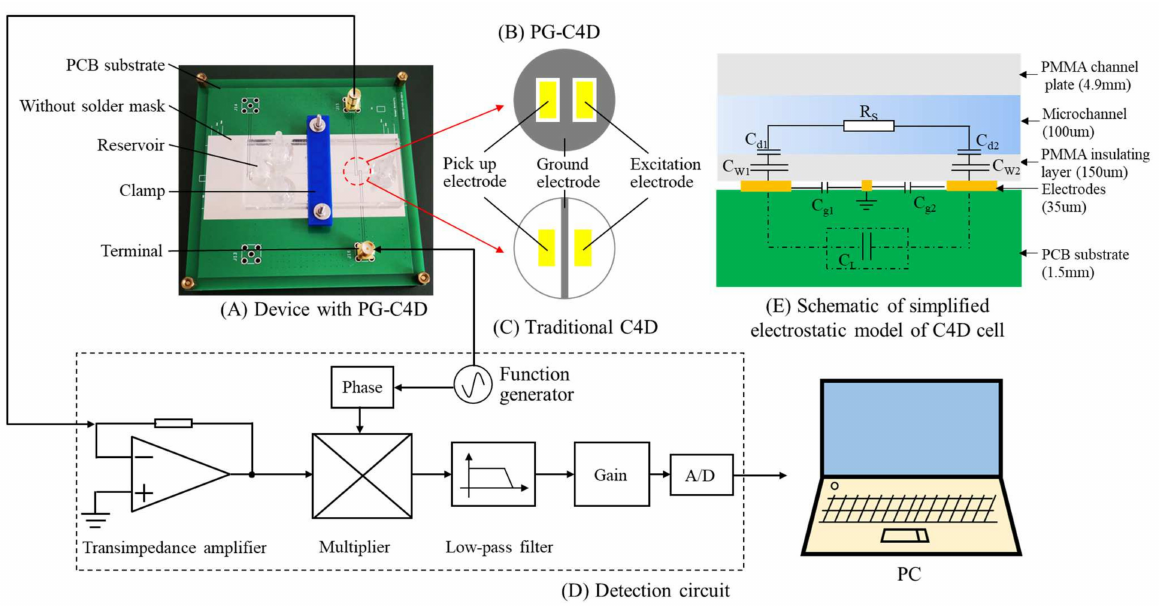
Figure 1. Schematic drawing of a microchip device with external C4D. ( A ) Device with PG-C4D ( B ) PG-C4D. ( C ) Traditional C4D. ( D ) Detection circuit. ( E ) Schematic of simplified electrostatic model of C4D